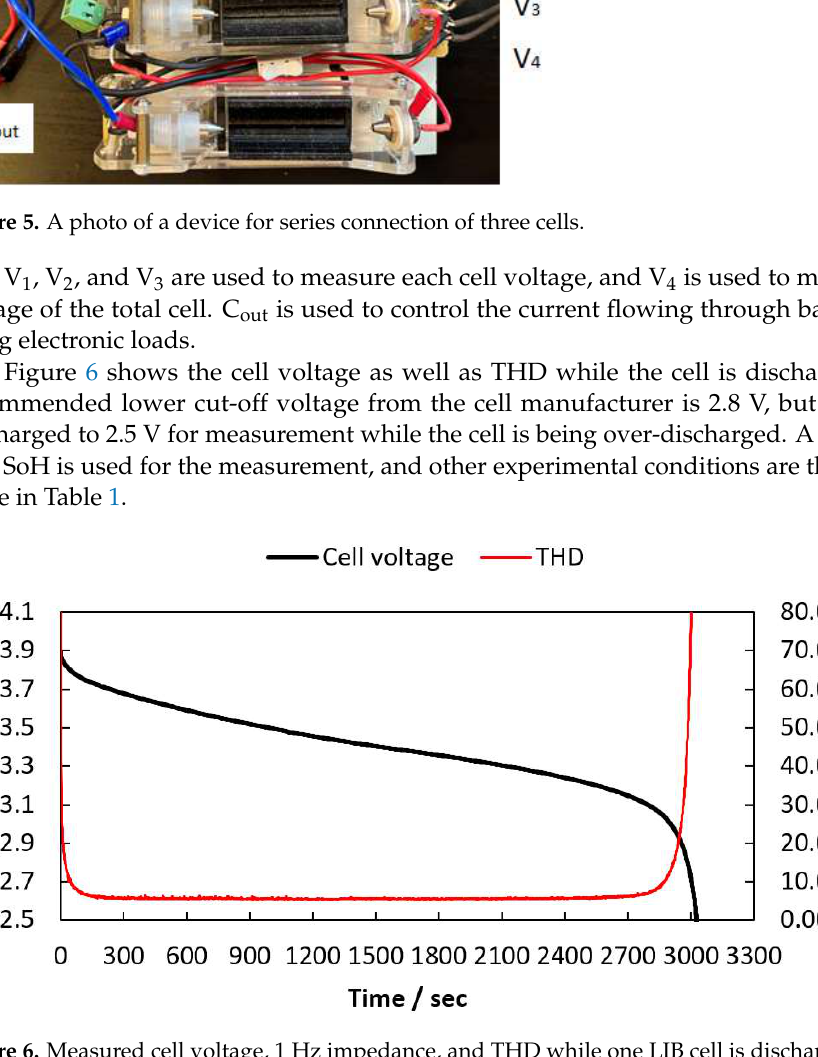
Figure 6. Measured cell voltage, 1 Hz impedance, and THD while one LIB cell is discharged.